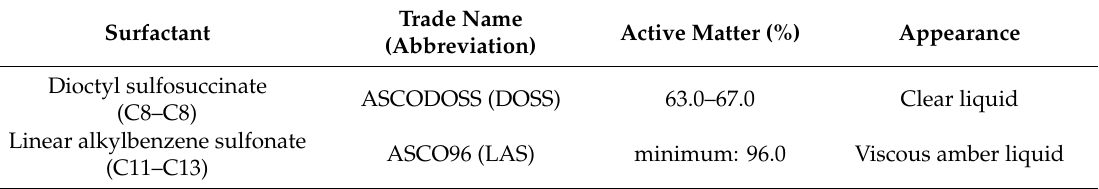
Table 2. Properties of available surfactants used in this